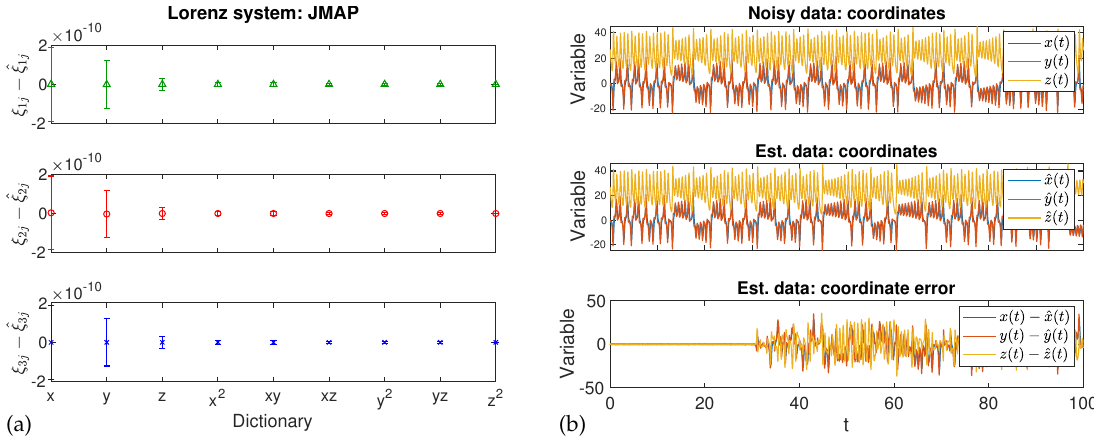
Figure 3. Output of JMAP regularization: ( a ) differences in predicted parameters ξ ij − ˆ ξ ij (the error bars indicate inferred standard deviations), and ( b ) comparison of original and predicted time series X